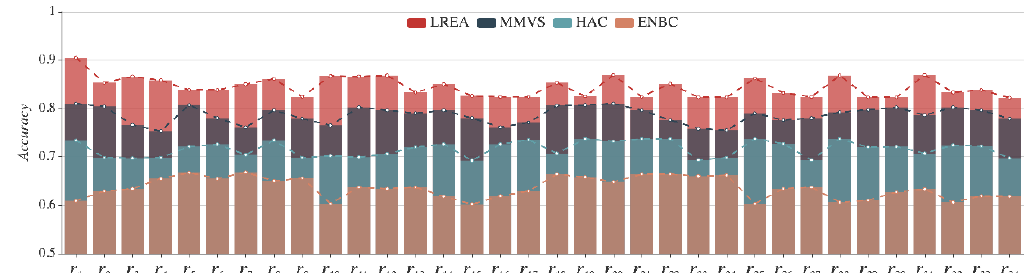
Figure 21. Evaluation accuracy rates of 34 local regions in 2017 with the four methods.